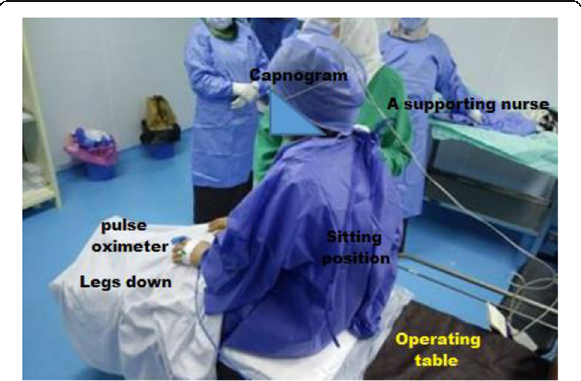
Fig. 1 Patient position during spinal